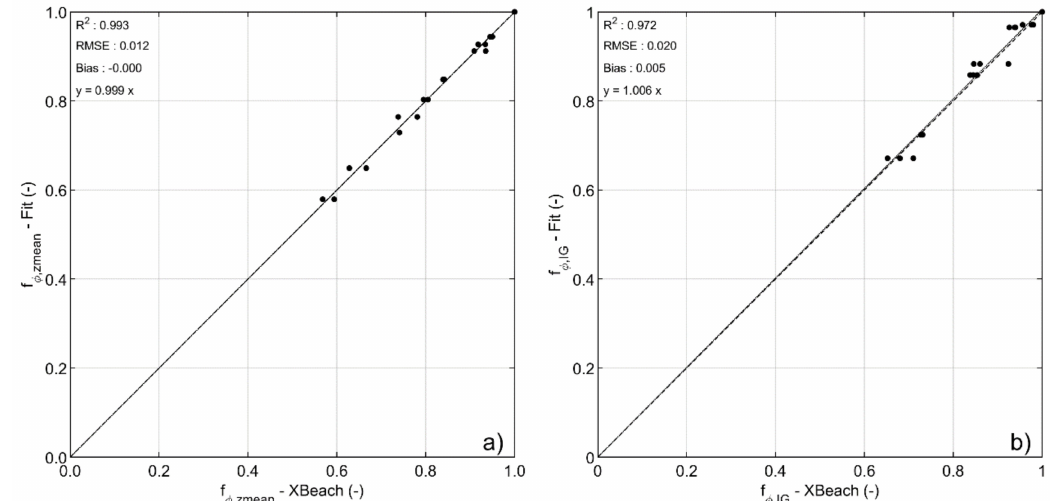
Figure 13. Comparison of simulated and computed wave angle reduction factors f ϕ for set-up ( a ) and infragravity run-up ( b ). Dashed line indicates unity (y = x).